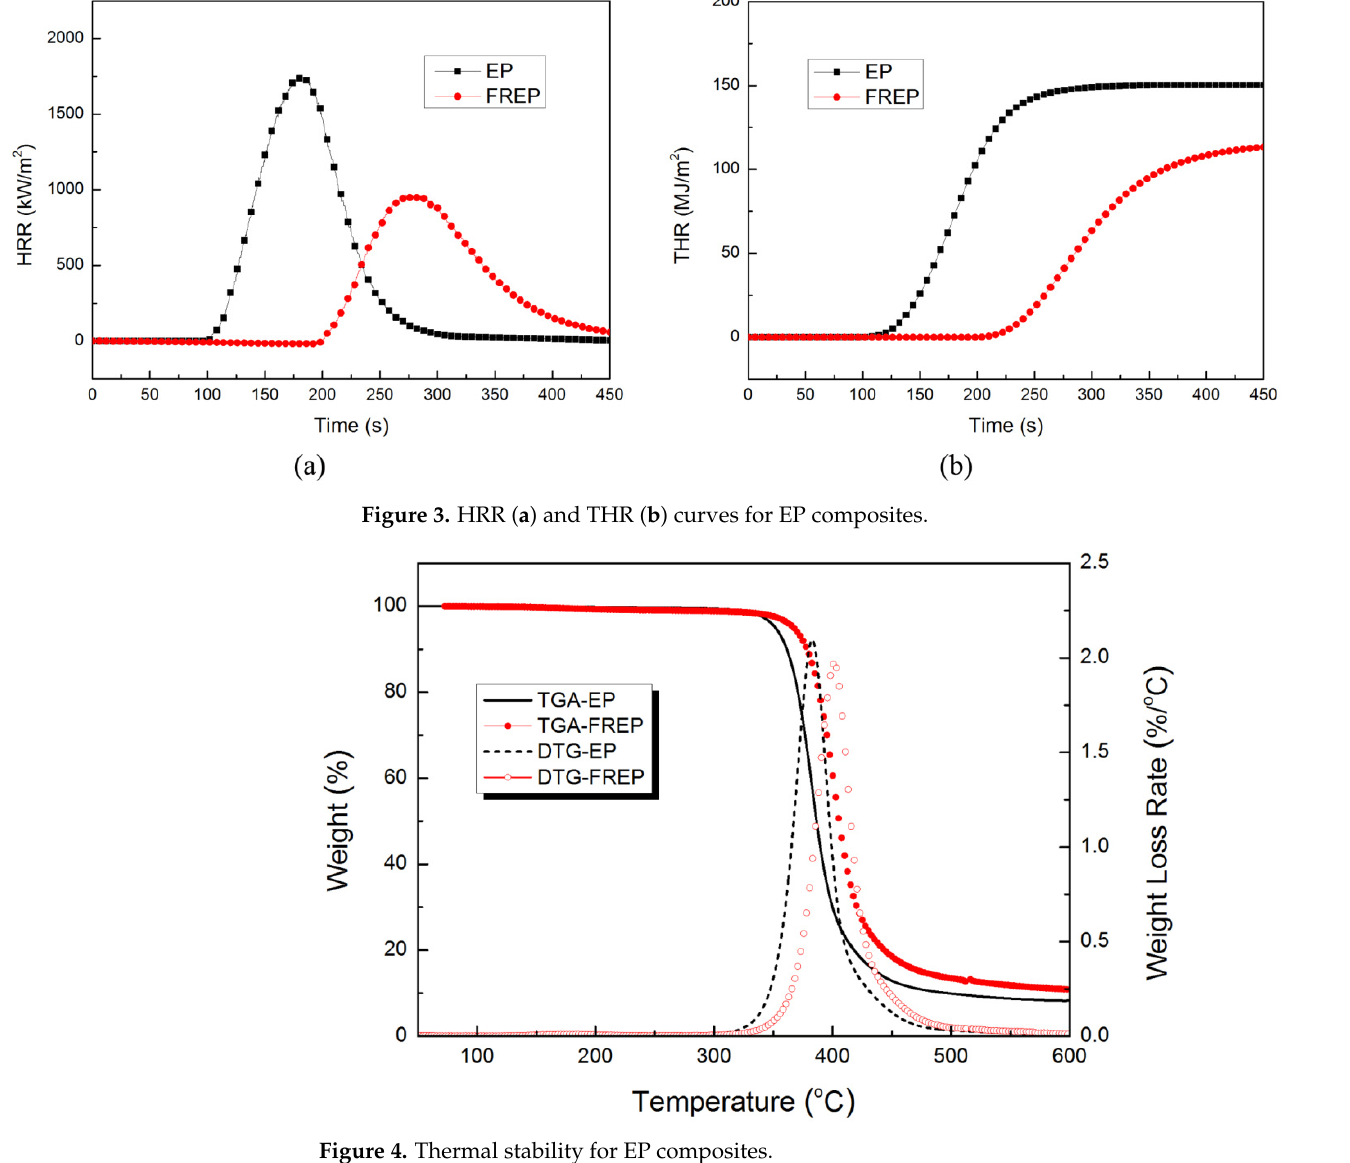
Figure 3. HRR ( a ) and THR ( b ) curves for EP composites.